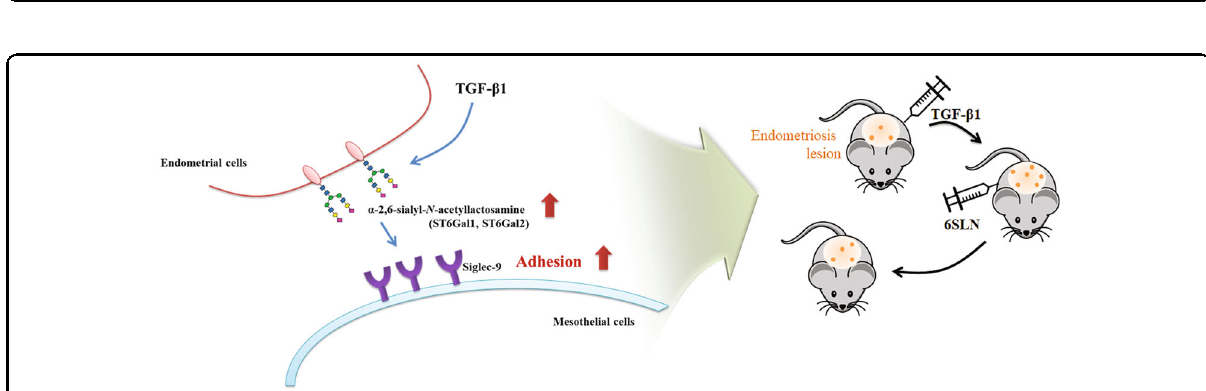
Fig. 7 Schematic presentation of TGF- β 1-induced adhesion of endometrium to mesothelium through the interaction between α 2-6 sialic acid